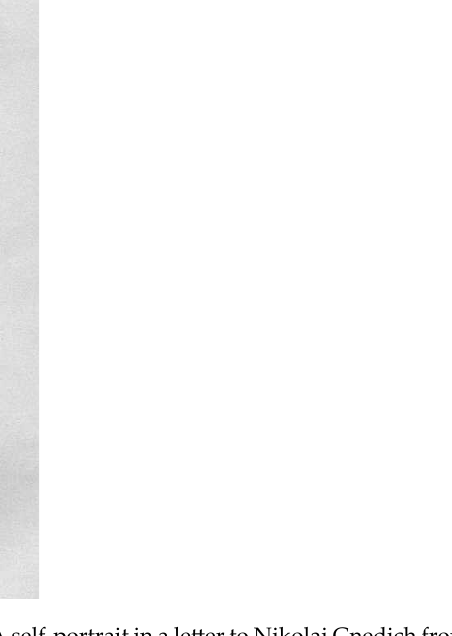
Figure 33. Konstantin Batiushkov. A self-portrait in a letter to Nikolai Gnedich from Riga, June 1807. Lost.